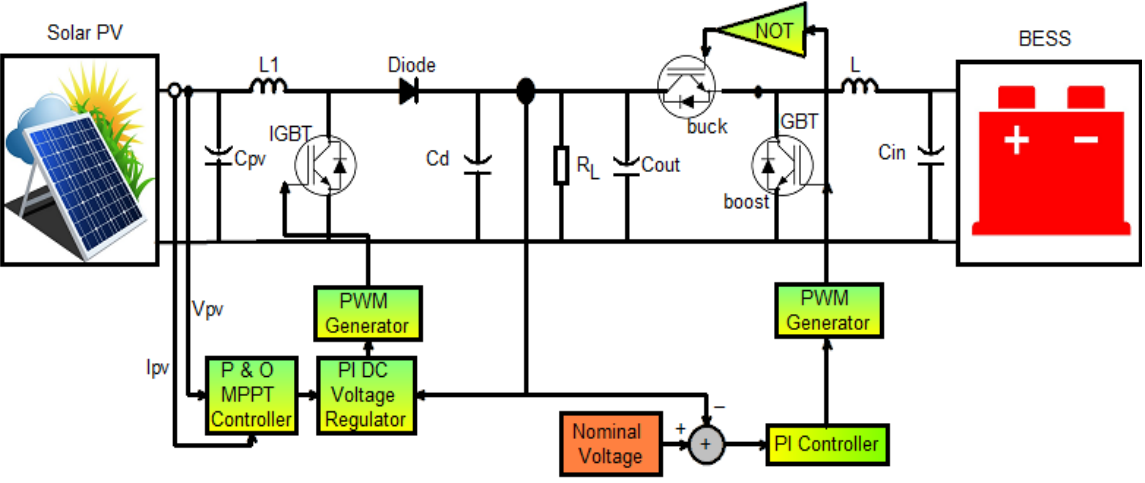
Figure 3. The block diagram of circuits and control mechanism of the booster and buck-boost con- verters.